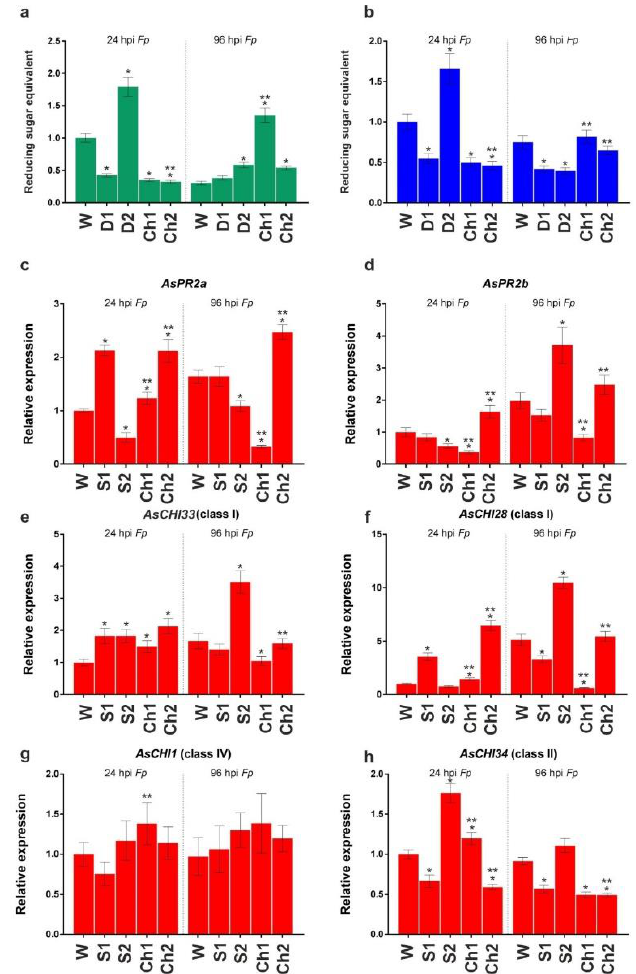
Figure 4. Total chitinase ( a ) and β-1,3-glucanase ( b ) activities and the expression of AsPR2a ( c ), AsPR2b ( d ), AsCHI33 ( e ), AsCHI28 ( f ), AsCHI1 ( g ), and AsCHI34 ( h ) genes in garlic roots pretreated with water (W), control solutions (S1, S2), and chitosan (Ch1, Ch2) and infected with F. proliferatum ( Fp ), at 24 hpi and 96 hpi. The expression data were normalized to GAPDH and UBQ mRNA levels, statistically analyzed with Graph Pad Prism version 8, and presented as the mean ± SE (n = 3) from three technical replicates of three biological replicates. * p < 0.01, compared to W control; ** p < 0.01, Ch1/2 compared to S1/2.